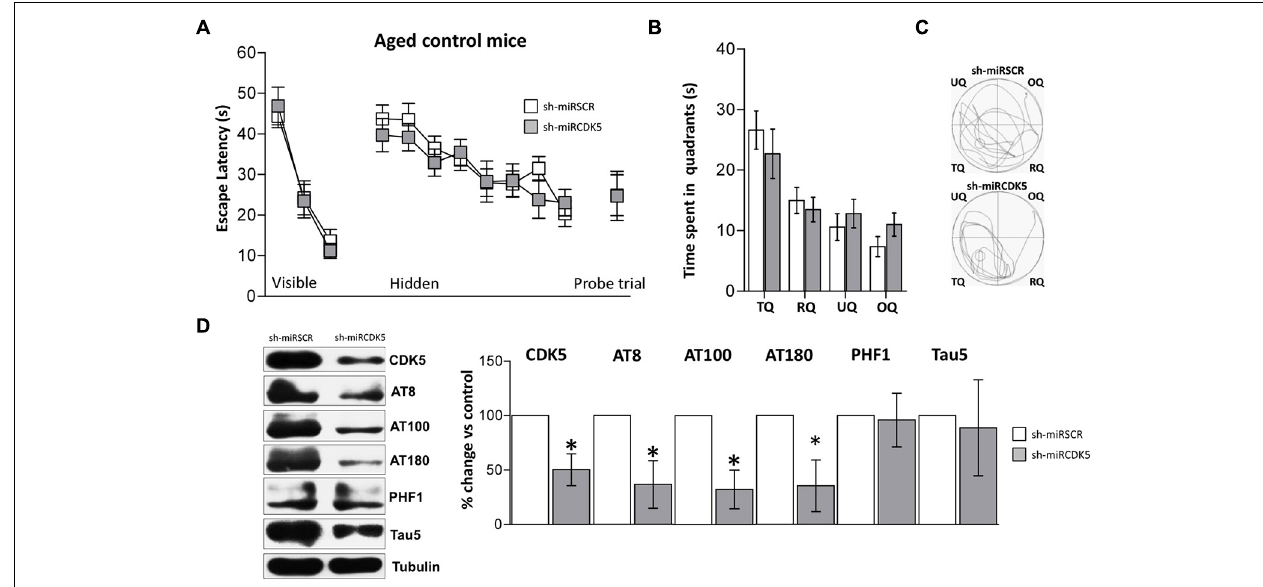
FIGURE 6 | CDK5 RNAi’s reduced phosphorylatedTau in control animals (littermates with only the PS1 M146V knock-in) but did not affect spatial memory. Morris Water Maze (MWM) testing was performed in 18-month-old control mice injected with shSCRmiR (white squares) and shCDK5miR (gray squares). (A) Values of latency to reach the visible and hidden platform during training and probe trial tests 48 h after training. (B) Time spent in the target quadrant and (C) path plots for the median path length during the probe trial. (TQ = target quadrant, RQ = right quadrant, UQ = upper quadrant and